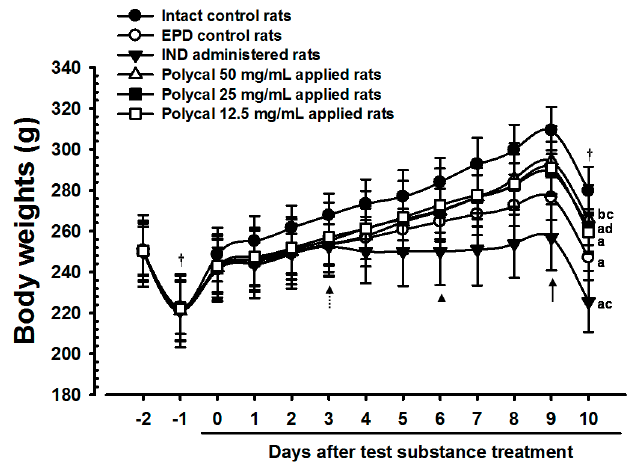
Figure 1. Body weights changes in Intact or EPD Rats. Note that significant ( p < 0.01 or p < 0.05) decreases of body weights were detected in EPD control from four days after ligature placement (from Day 3 after initiation of administration) as compared with Intact control (dot arrow). However, the body weights of all three concentrations of Polycal topical applied rats were markedly increased as compared with EPD control from nine days after start of administration (arrow). In contrary, significant ( p < 0.01 or p < 0.05) decreases of body weights were detected in IND 5 mg/kg orally administered rats from six days after initiation of administration as compared with EPD control (arrowhead), in this experiment. Values are expressed mean ± S.D. of eight rats. EPD = Experimental periodontal diseases induced by ligature placement around the cervix of upper left incisor teeth; Polycal = Polycan and calcium gluconate 2:98 (g/g) mixture, which was topically applied to ligated gingival regions, once a day for 10 days (200 μ L/rats); IND = Indomethacin, which was orally administered at 5 mg/kg dose level, once a day for 10 days; The day − 1 means the day of ligature placement. All rats were overnight fasted before ligature placement and sacrifice, respectively (†). a p < 0.01 and b p < 0.05 as compared with Intact control; c p < 0.01 and d p < 0.05 as compared with EPD control.